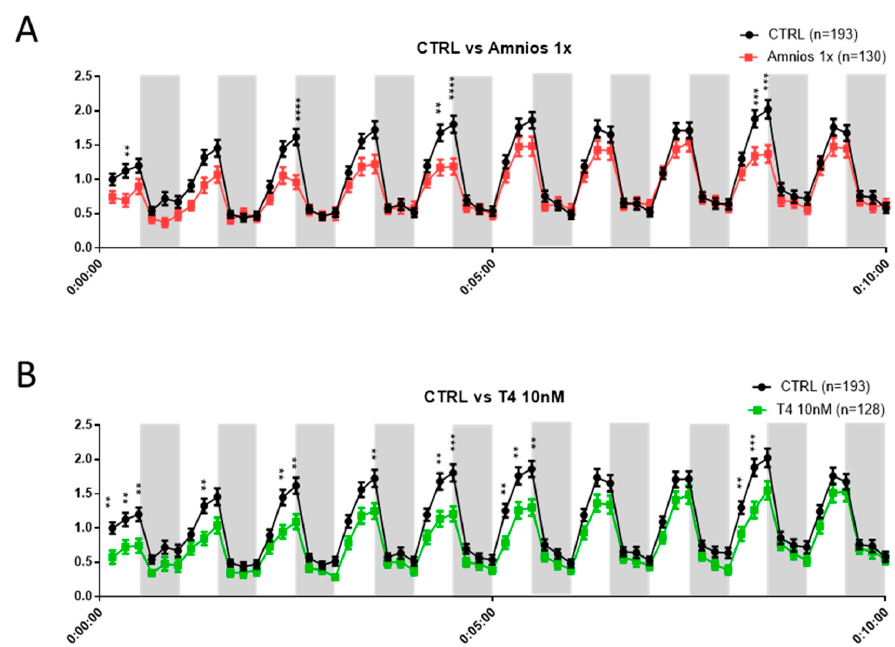
Figure 6. Effect of Amnios 1X and T 4 on proliferation and apoptosis in tadpole brains. For each treat- ment group, 2 tadpoles from 3 different females were analyzed. ( A ) Example cross-sectional images of brains following immunochemistry: apoptosis marker in red (caspase3), proliferation marker in green (PH3). Scale bar, 100 µm. ( B ) Average number of positive cell nuclei per section for caspase3 and PH3, and the ratio of proliferative/apoptotic cells.